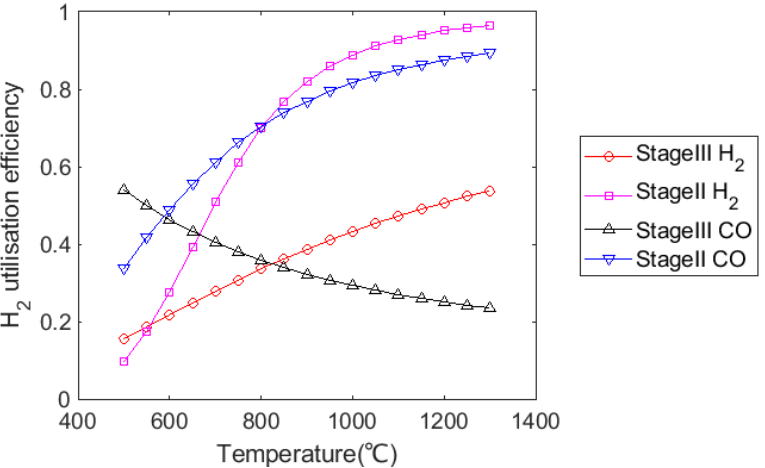
Figure 4. Variation in gas utilisation efficiency for iron ores reduction in pure H 2 or CO with tem-